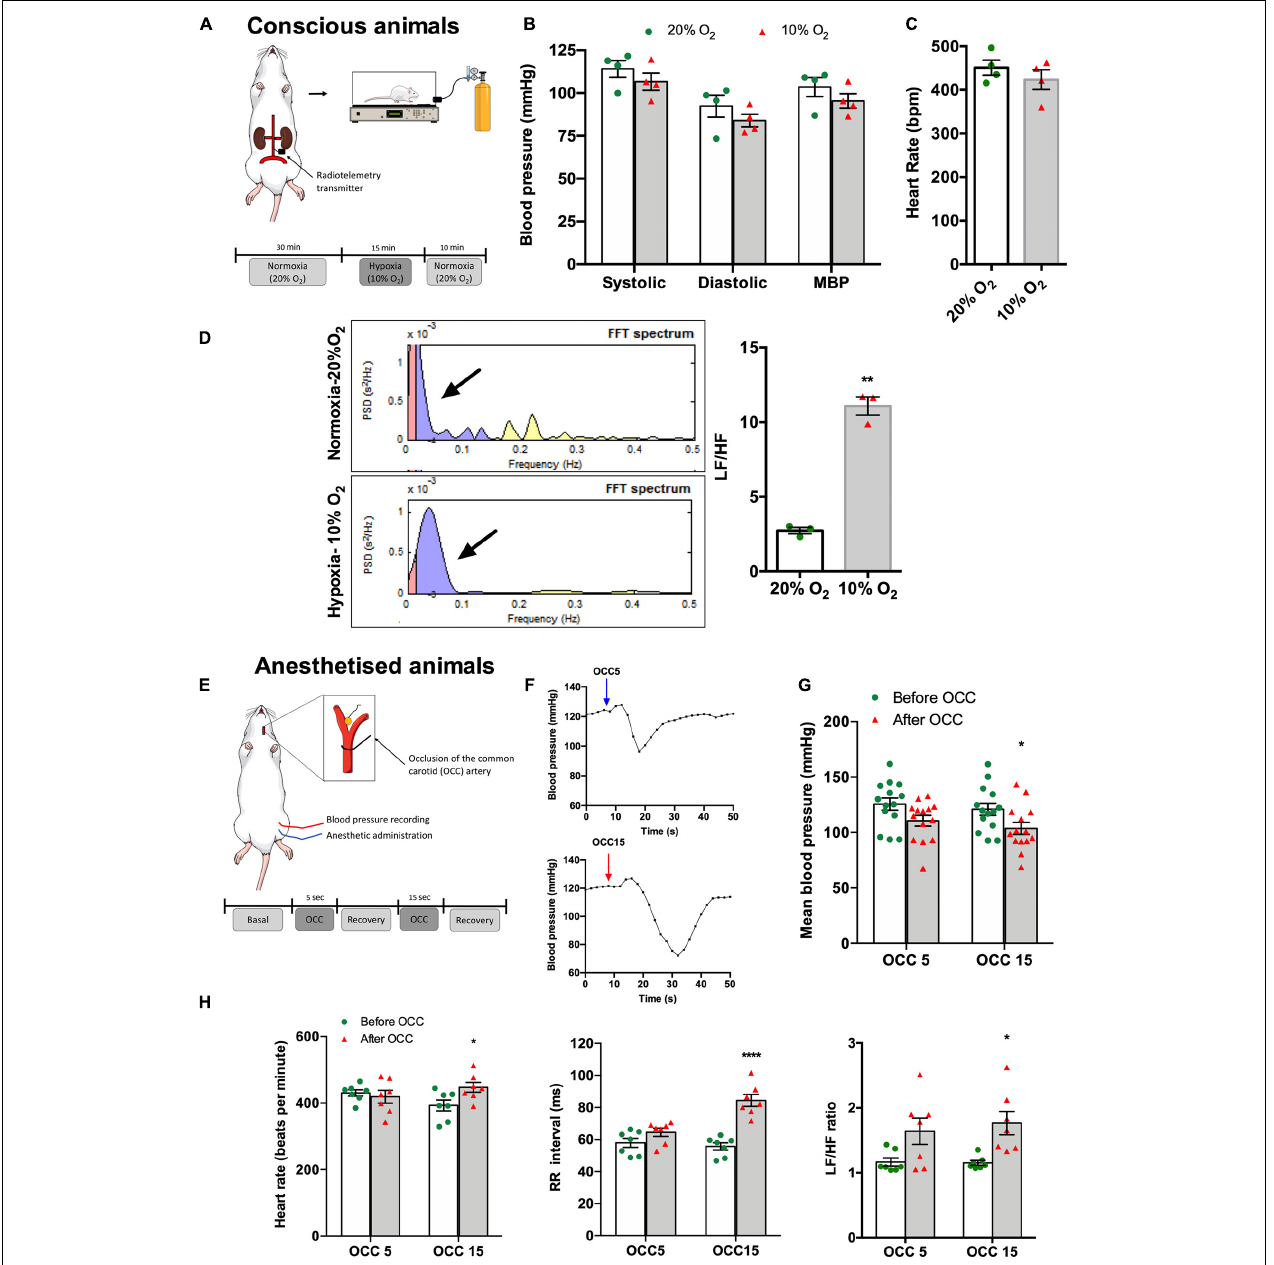
FIGURE 1 | Effect of hypoxic and ischemic hypoxia on blood pressure, HR, and autonomic nervous system activity in conscious (A–D) and anesthetized animals (E–H) . (A) Schematic representation of the experimental protocol used to assess the effect of hypoxic hypoxia on physiological variables recorded in four conscious animals. Animals implanted with telemetry devices for blood pressure recording were submitted to 15 min of 10% O 2 (balanced N 2 ) after 30 min of baseline recording at normoxia (20% O 2 balanced N 2 ), n = 4. (B) Effect of hypoxic hypoxia on SBP, DBP, and MBP when compared with normoxia. (C) Effect of hypoxic hypoxia on HR ( n = 4). (D) Effect of 15 min exposure to hypoxic hypoxia on autonomic function assessed by spectral analysis of HR. The left panel shows control examples of power spectral density in normoxia, n = 4 (top), and hypoxia, n = 3 (bottom). Frequencies are presented in normalized units. The right panel shows mean values of autonomic function assessed by the ratio between the percentage of Lf that represents the sympathetic component of the autonomic nervous system and the percentage of Hf that represents the parasympathetic component of the autonomic nervous system. (E) Schematic representation of the experimental protocol used to assess the effect of ischemic hypoxia on anesthetized animals. (F) Typical blood pressure responses to ischemic hypoxia assessed as OCC of 5 (top) and 15 s (bottom) of intensities. (G) Effect of 5 and 15 s OCC on MBP ( n = 14). (H) Effect of 5 and 15 s of ischemic hypoxia on HR (left panel), on the RR intervals (middle panel), and autonomic function assessed by the spectral analysis of the HR and expressed as the ratio between the Lf and Hf of the spectra (right panel) ( n = 7). Bars represent mean ± SEM. Shapiro–Wilk normality tests were performed, and all groups passed normality test. Whenever two groups were compared, two-tailed Student’s t -test was executed (C,D) , and when more than two groups were compared, two-way ANOVA with Bonferroni’s multiple comparison test was performed (B,G,H) ; * p < 0.05, ** p < 0.01, **** p < 0.0001 comparing values before and after the OCC.